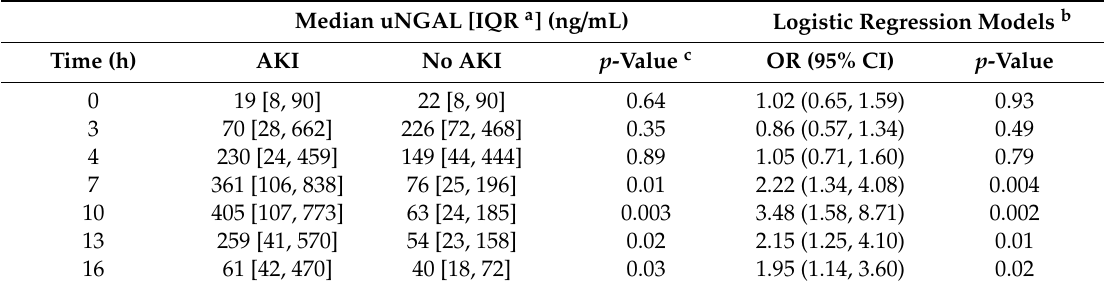
Table 3. Median [IQR] uNGAL values at urine collection intervals for neonates with and without AKI. Odds ratios for AKI versus No AKI derived logistic regression models at each uNGAL collection